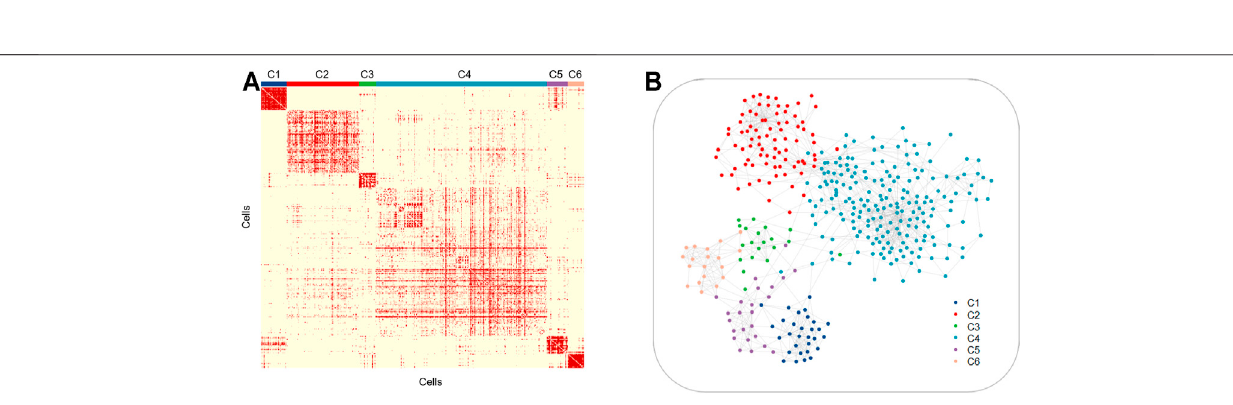
Frontiers in Genetics |